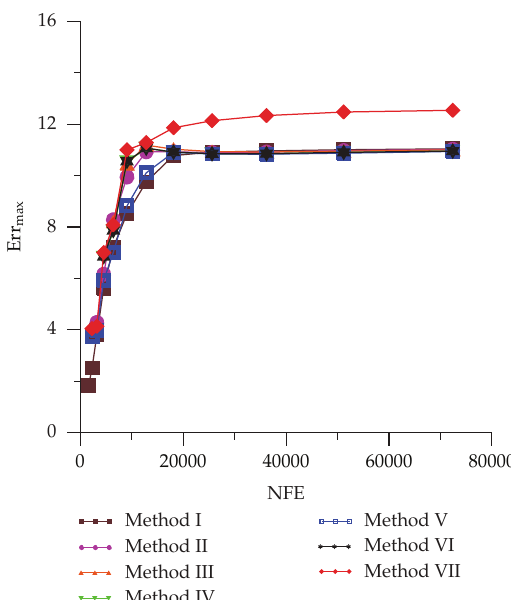
Figure 4: Err max for several values of the number of function evaluations (cid:4) NFEs (cid:7) for the Methods I–IV for Du ffi ng’s. The nonexistence of a value of Err max indicates that for these values Err max is negative.